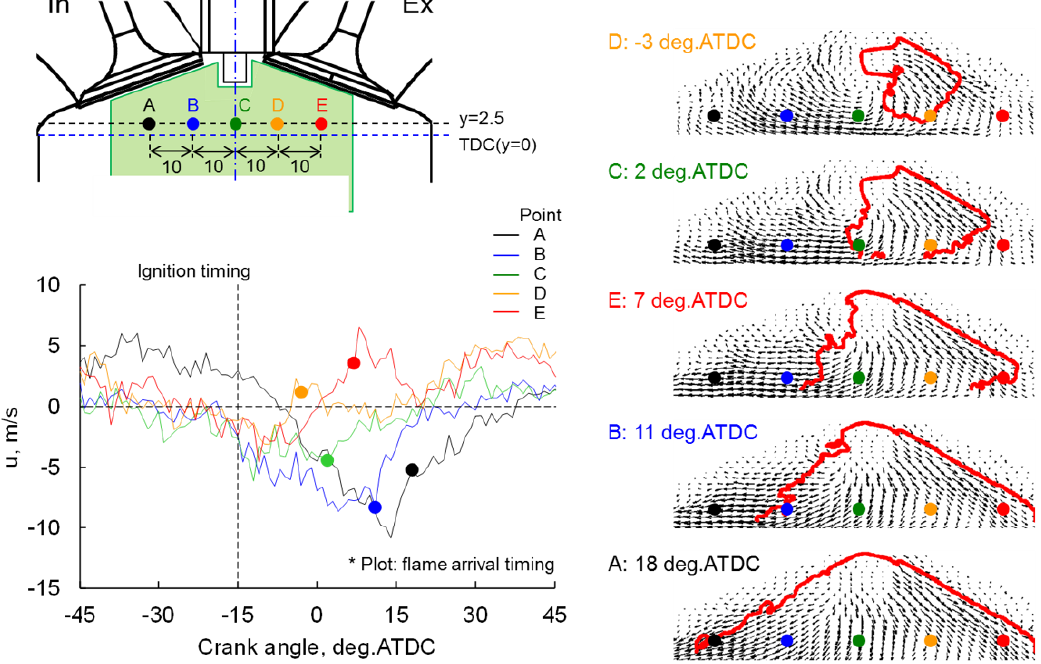
Figure 11. Velocity of the in-cylinder mixture flow at many different points as the flame front approaches and passes through those selected locations.